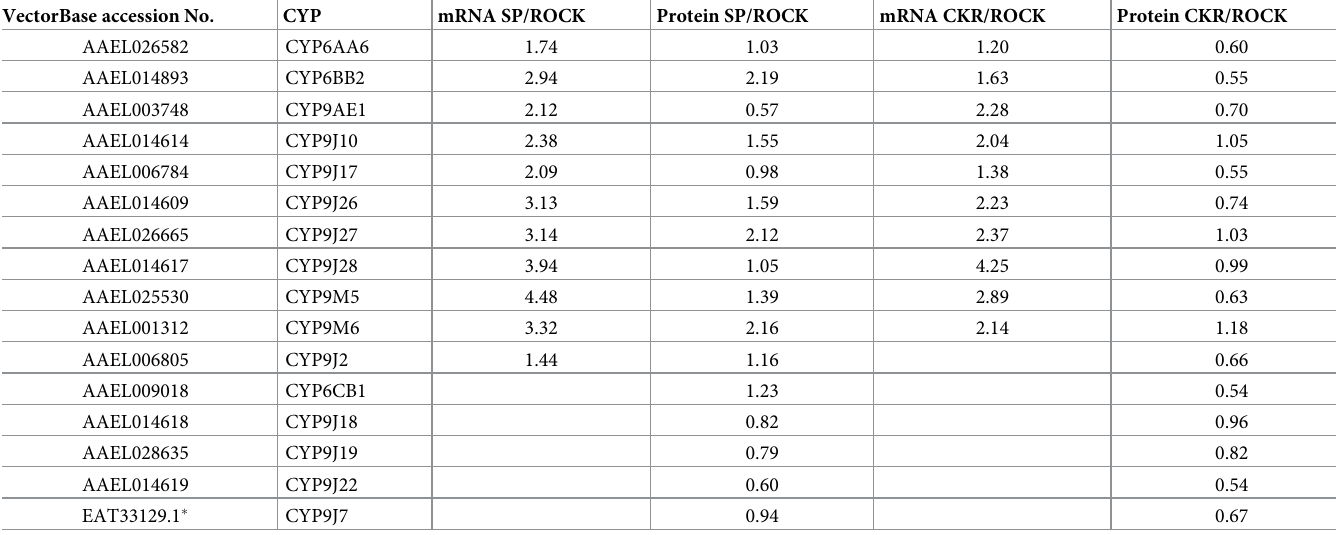
Table 2. Summary of CYPs that were overexpressed in transcriptomic and/or proteomic analyses. VectorBase accession No.